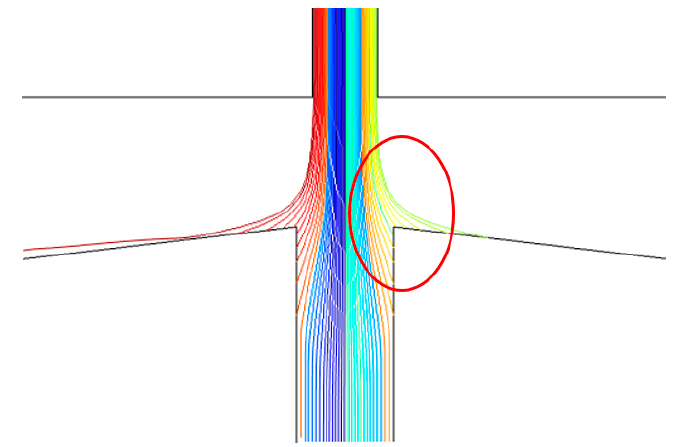
Figure 6. Movement of particles at L = 400 µ m.